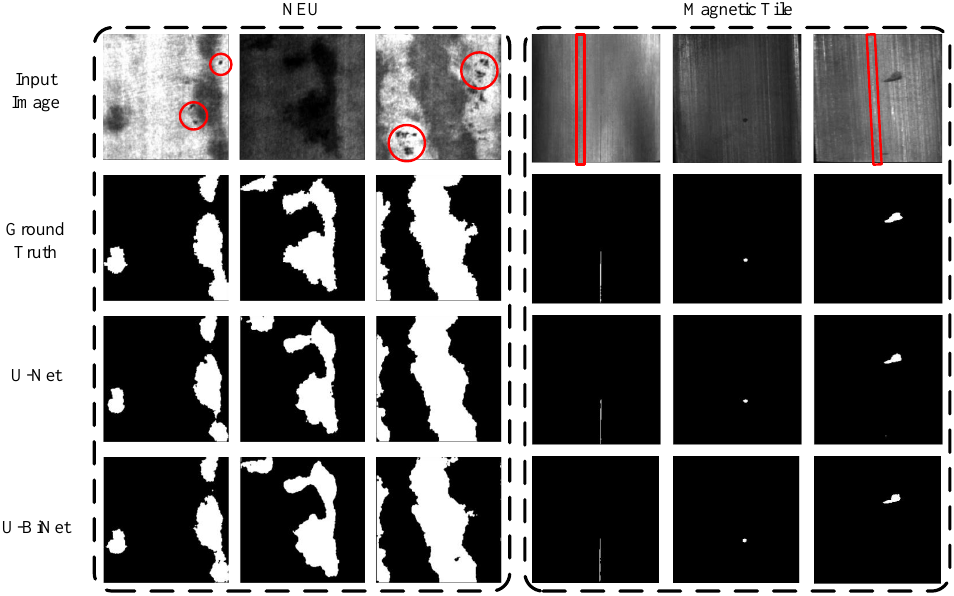
Figure 1. From top to bottom: input images; pixel-wise annotation of corresponding input image; prediction of full-precision U-Net and prediction of U-BiNet in